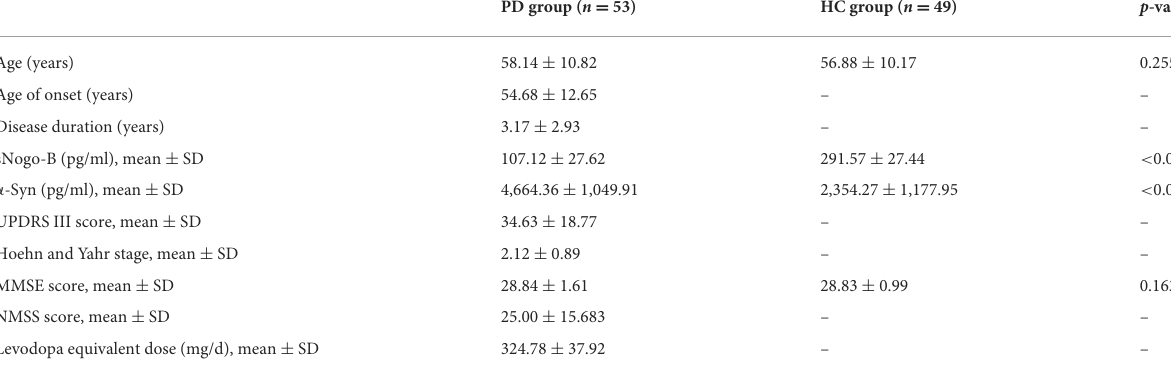
TABLE 1 Demographic and clinical features of patients with PD and healthy